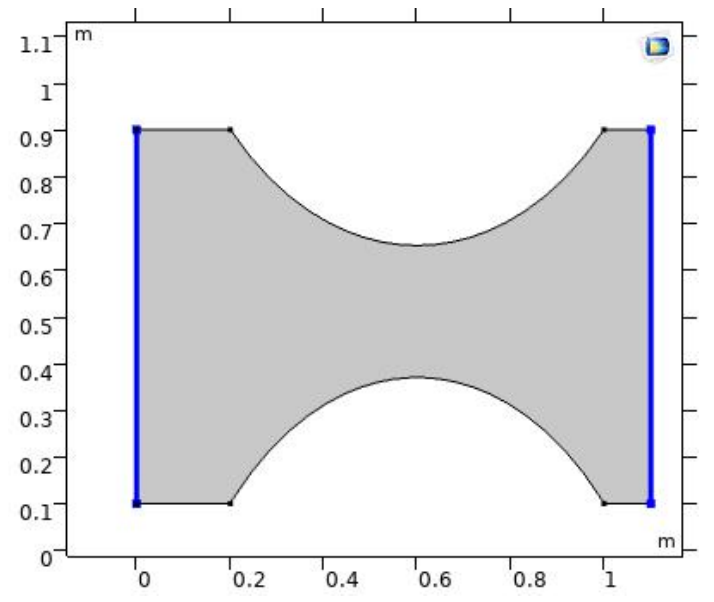
Figure 5. The thermal insulated boundaries of the